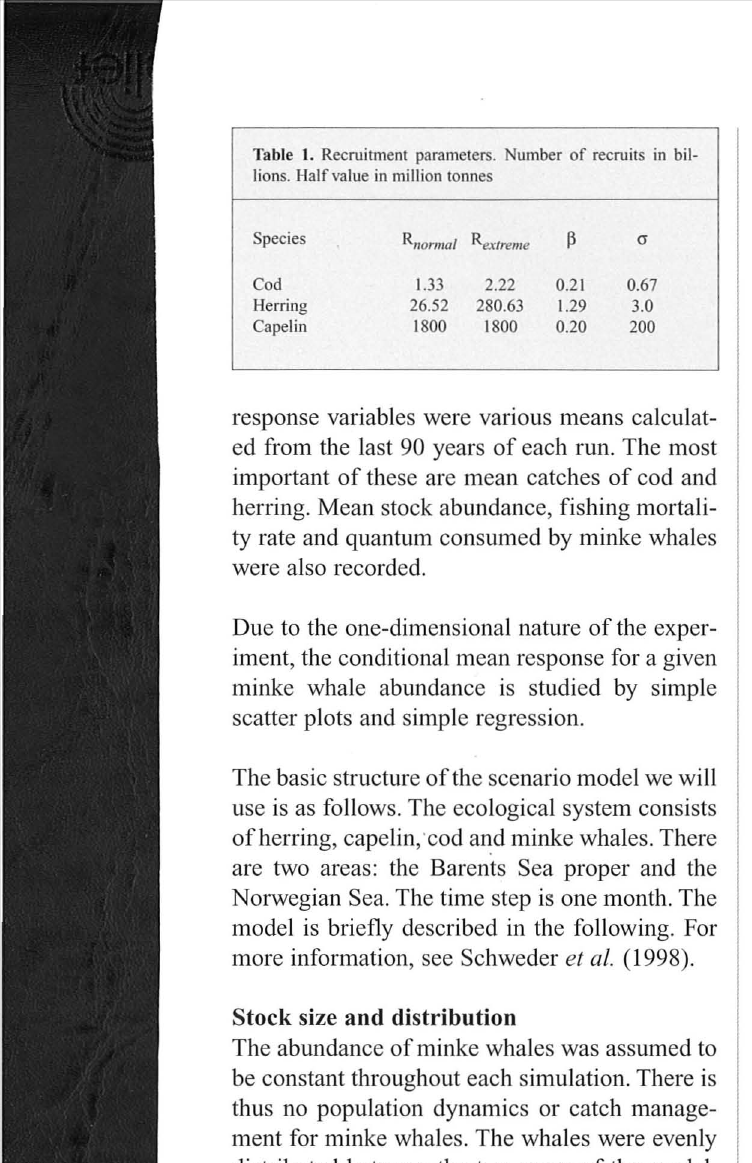
Table I. Recruitment parameters. Number of recruits in bil lions. Half value in million tonnes